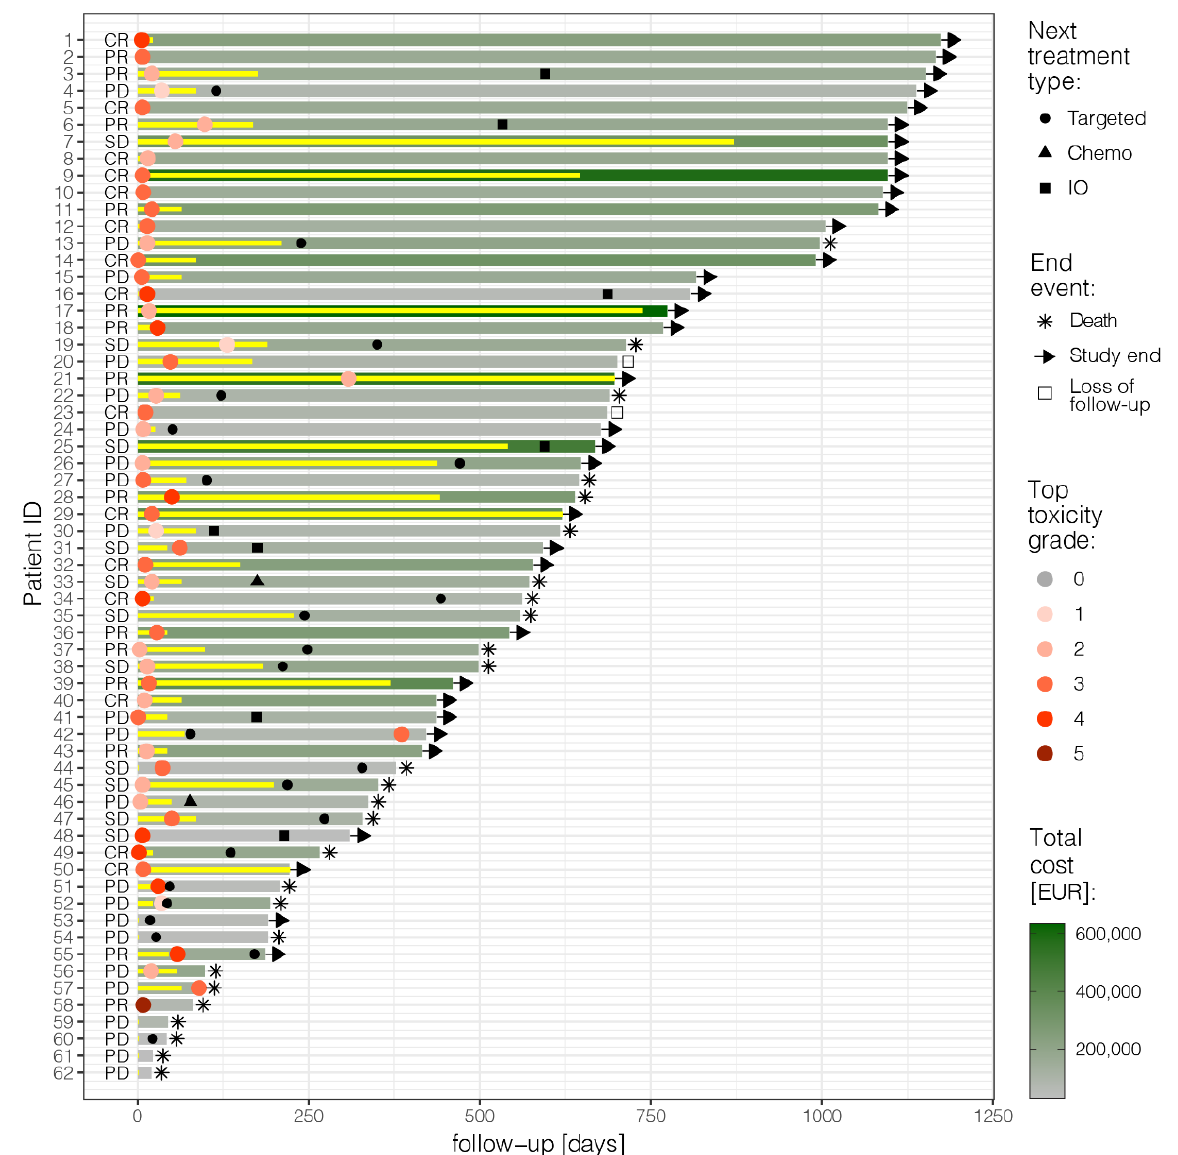
Figure 1. Swimmer plot: follow-up of each patient from the start of ipilimumab–nivolumab until death, study end, or loss of follow-up; treatment duration (yellow bars); best overall response following RECIST 1.1 (CR: complete response, PR: partial response, SD: stable disease, PD: progressive disease); maximum toxicity grade experienced (red dots); next treatment line (black symbols); and total cost (shades of green). Figure produced in R v4.0.3 [19] using ggplot2.